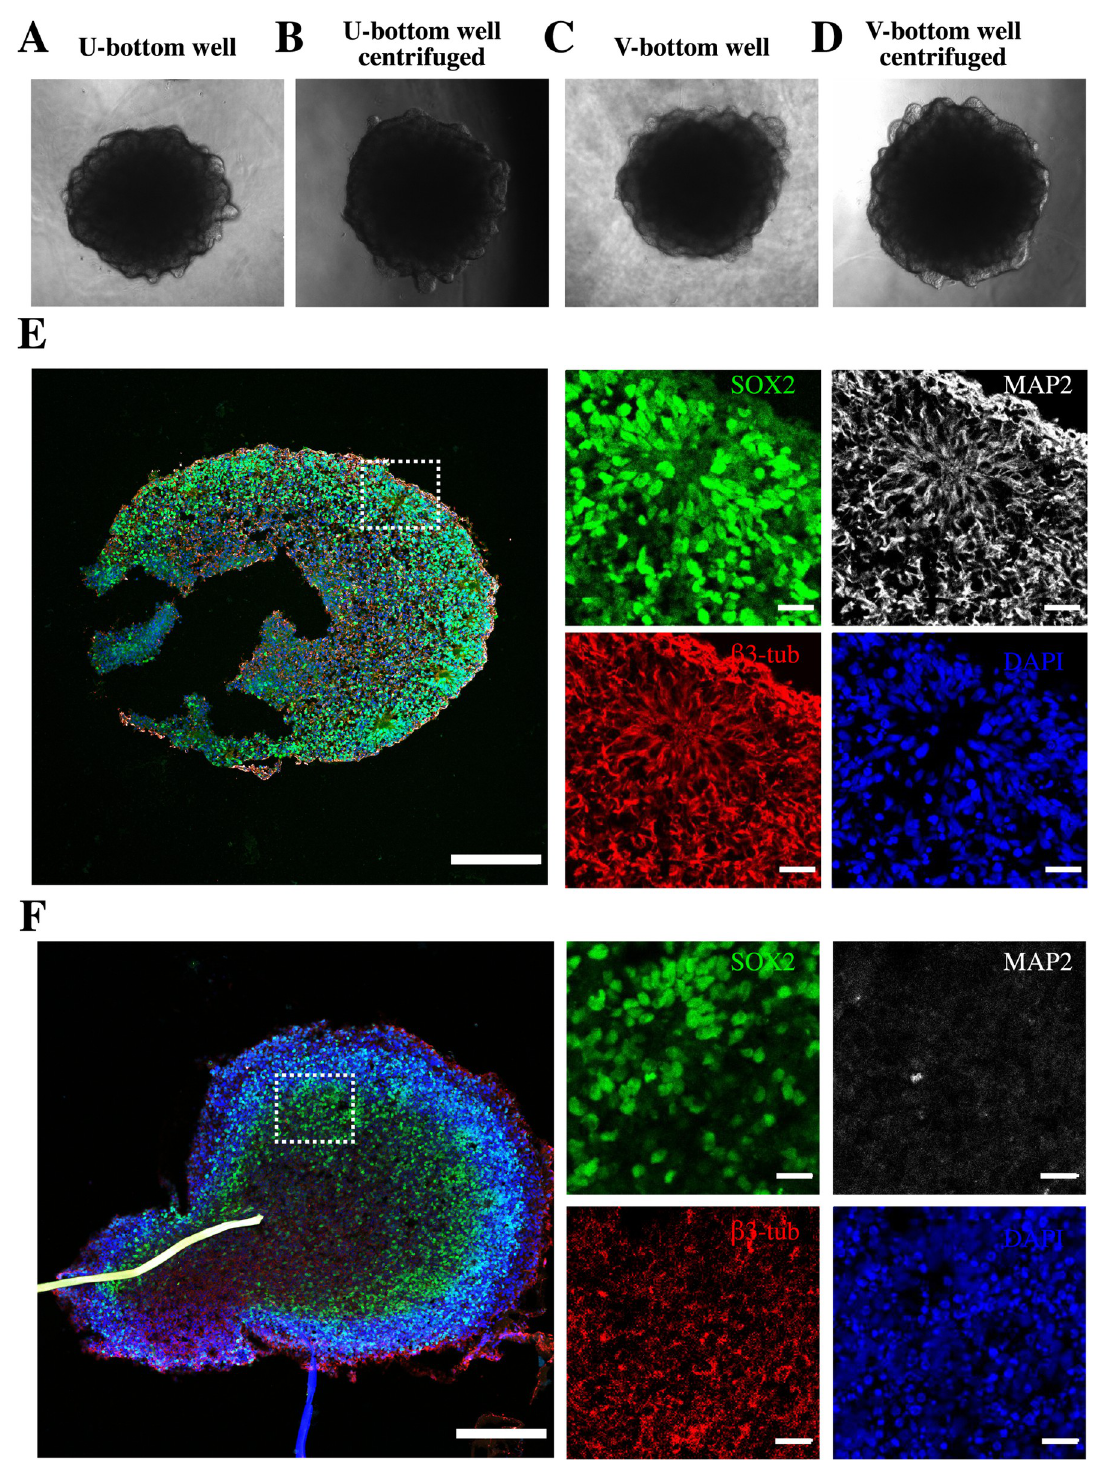
Fig 5. Examples of successful organoid differentiation from EBs. Brain organoids were formed using guided and unguided differentiation protocols to induce telencephalic differentiation. Regardless of the use of U- or V-bottom wells, the EBs demonstrated budding neuroepithelia at the periphery, hinting at successful organoid formation. Examples of EBs produced in a (A) a U-bottom well without centrifugation, (B) a U-bottom well with centrifugation, (C) a V-bottom well without centrifugation, and (D) a V-bottom well with centrifugation. Scale bar: 500 μ m. (E-F) Successful organoid differentiation at 30 daysof culture. Dotted lines indicate the